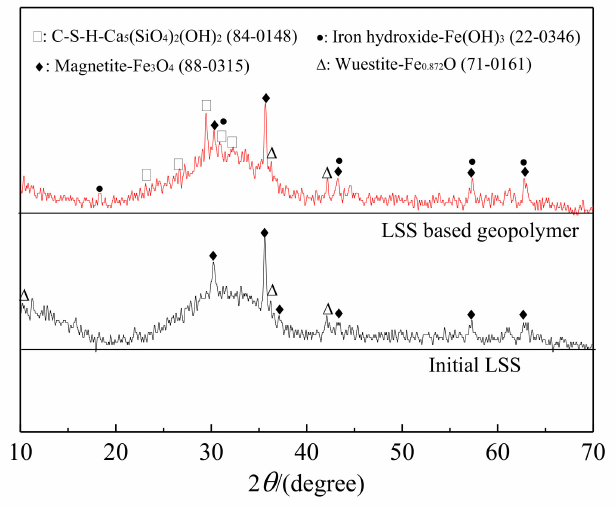
Figure 5. XRD patterns of the initial LSS and LSS based geopolymer (R 2 ) after being hydrated for 28